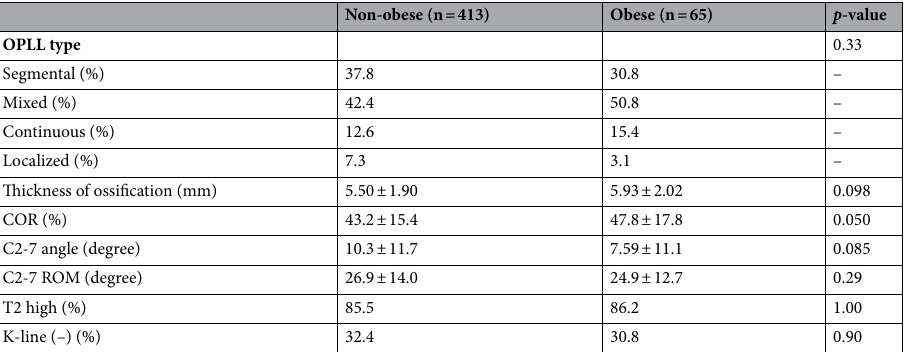
Table 2. Radiographical features of non-obese and obese groups. Non-obese: BMI < 30.0 kg/m 2 ;